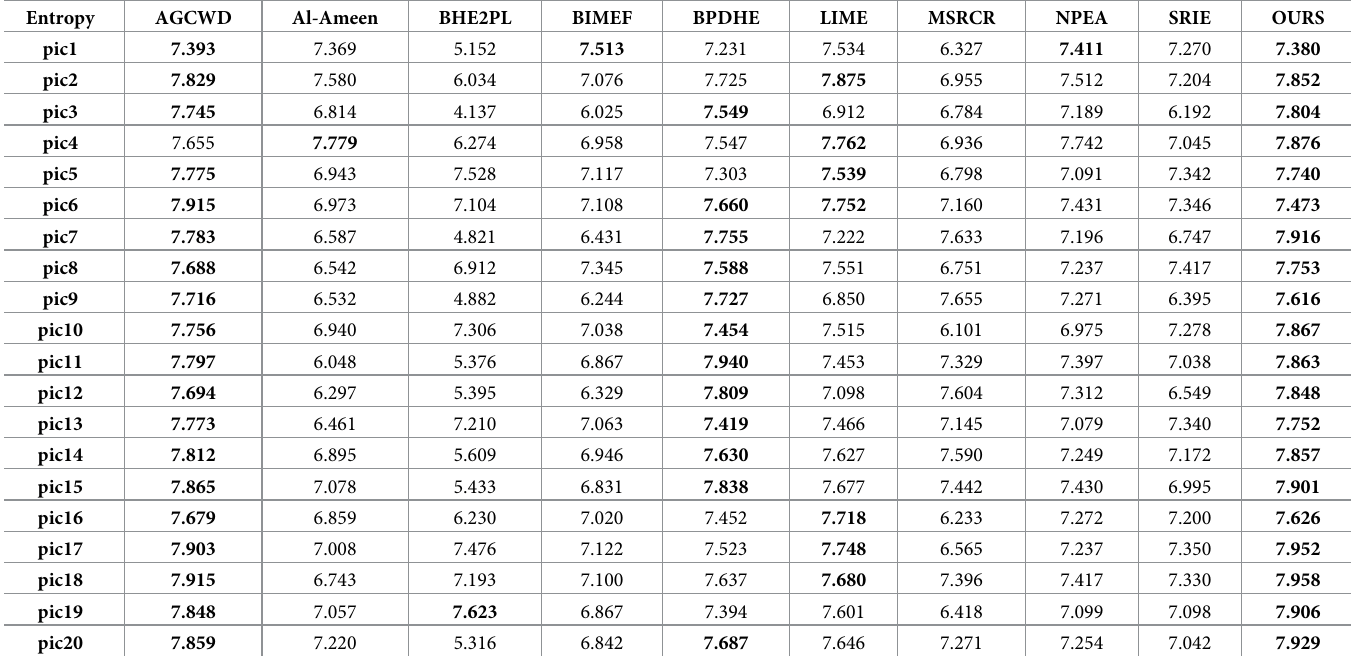
Table 7. Image information entropy values of 20 random images of MIT-5K.